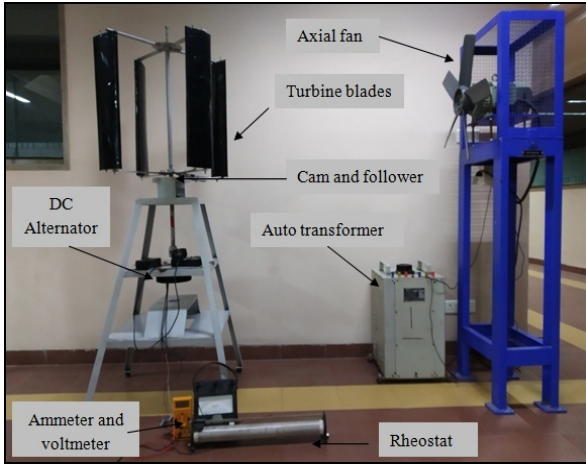
Figure 10. Photo of the experimental setup